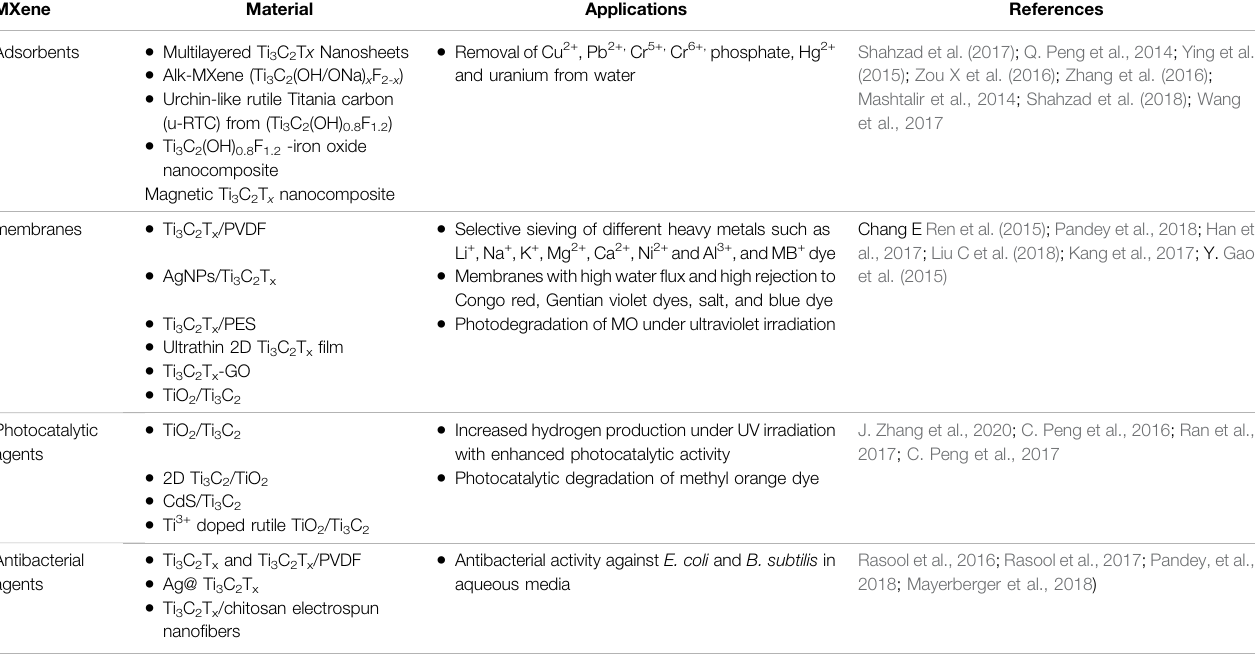
TABLE 3 | Selected examples of the utilization of MXenes for water puri fi cation (adapted from Rasool et al. (2019)). MXene Material Applications